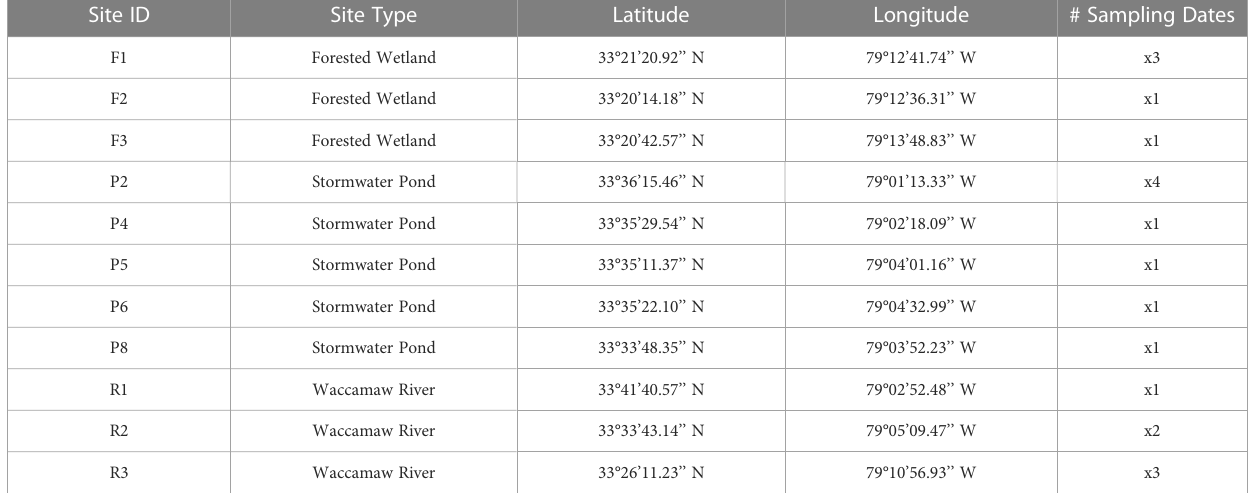
TABLE 1 Sampling site